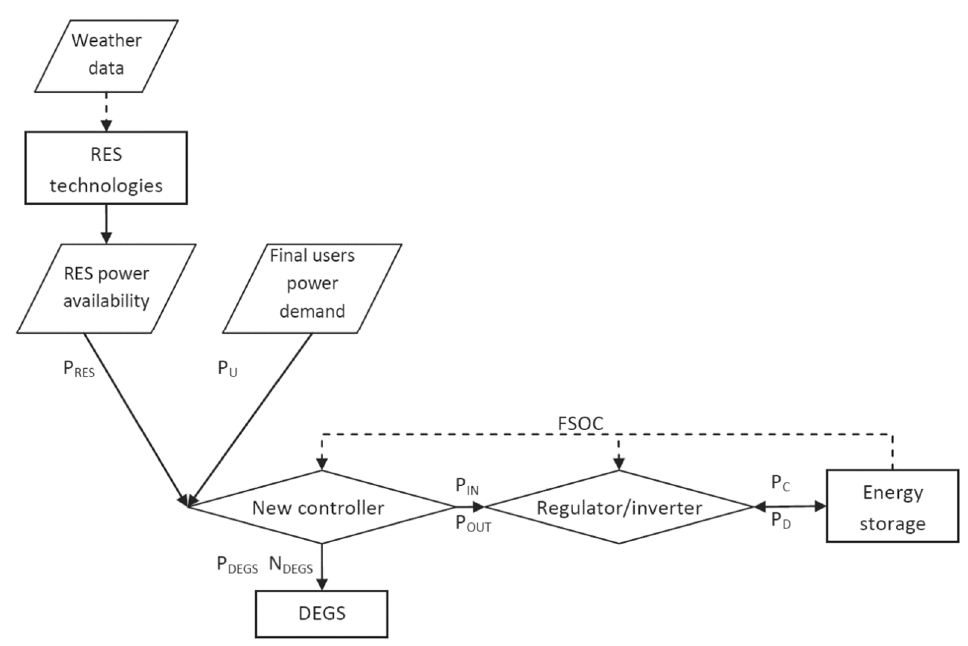
Figure 3. Energy systems in scenarios 1 and 2 .